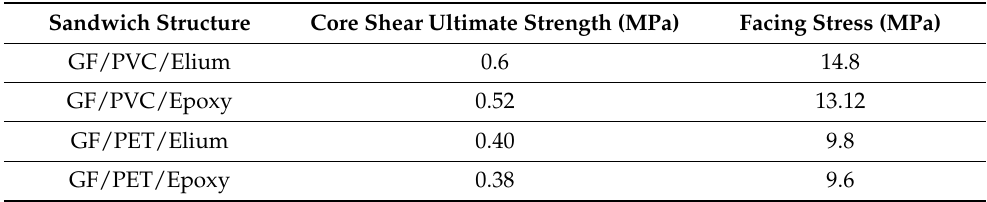
Table 5. Core shear test results of sandwich